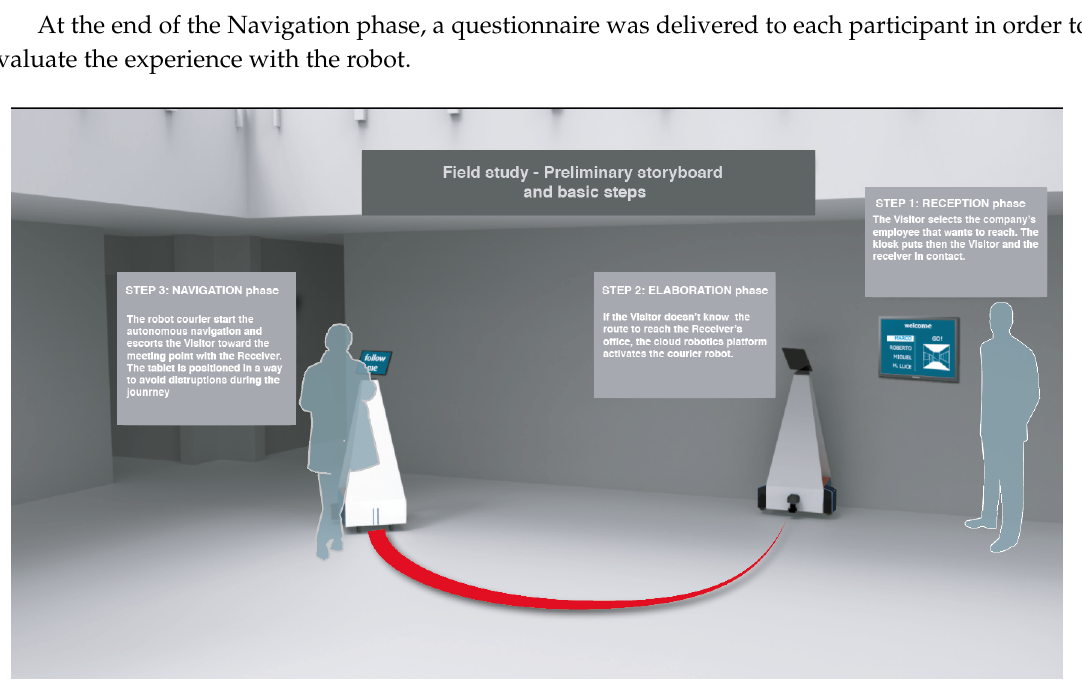
Figure 7. The three basic steps that defined the major moments of the field study for the evaluation